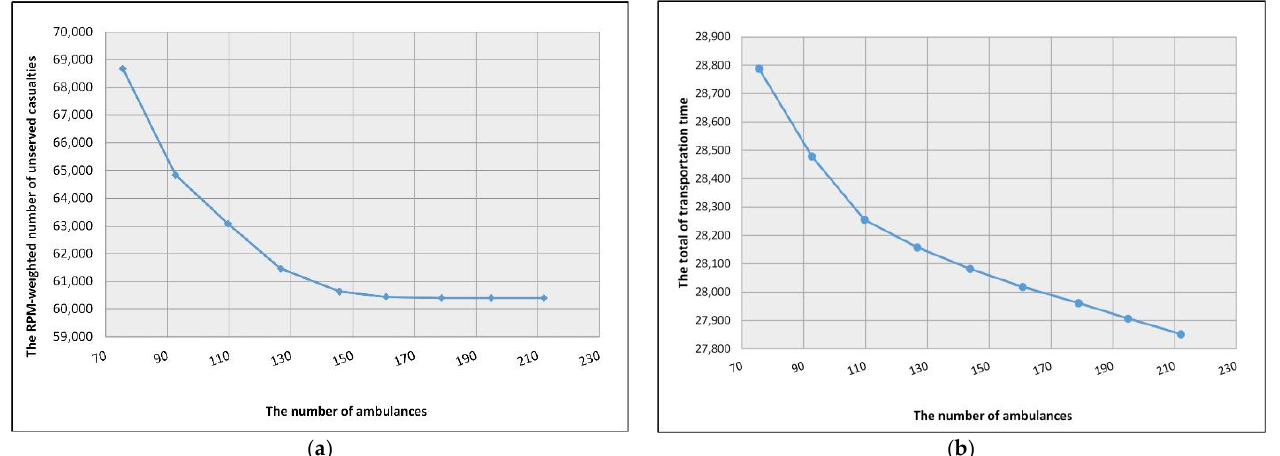
Figure 4. The effects on the number of ambulances on ( a ) the sum of Respiratory rate, Pulse rate, and Motor response values (RPM)-weighted number of unserved casualties and ( b ) transportation time.